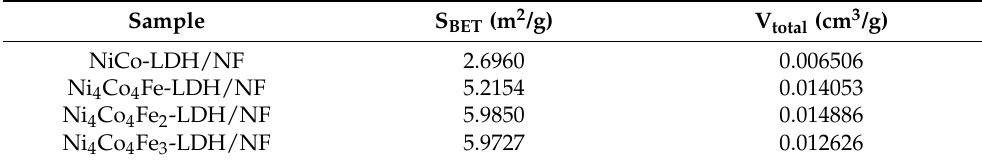
Table 2. Specific area and pore volume of the samples.